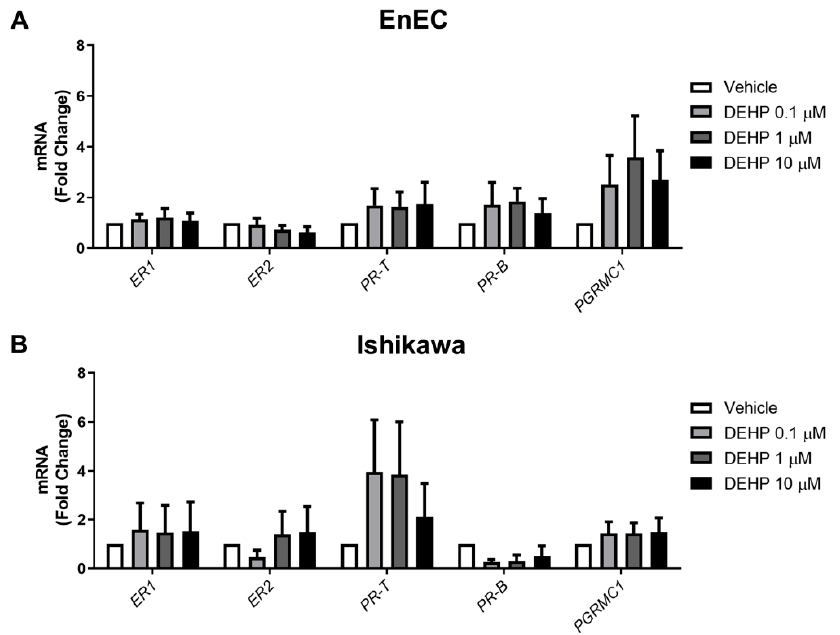
Figure 3. Steroid receptor mRNA in primary EnEC and Ishikawa cells following acute DEHP exposure. After acute DEHP exposure in the primary EnEC ( A ) and Ishikawa cells ( B ); qPCR was performed to measure the expressions of ER-1, ER-1, PR-T, PR-B, and PGRMC1. The results are shown as the mean ± SD for the data of six different samples in the case of EnEC and three independent experiments in the case of Ishikawa cells.